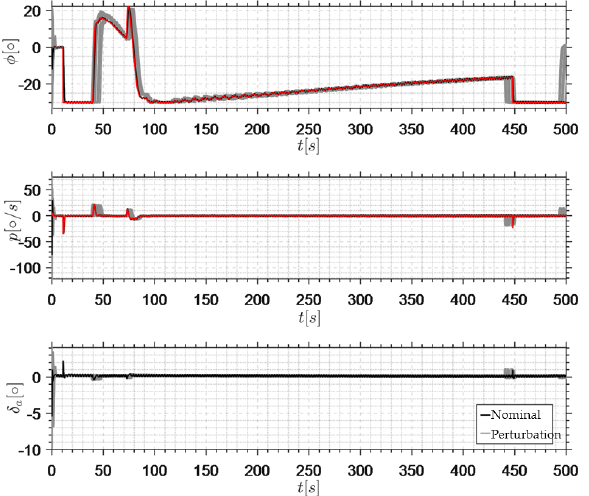
Figure 26. Perturbation simulation of unpowered return rolling